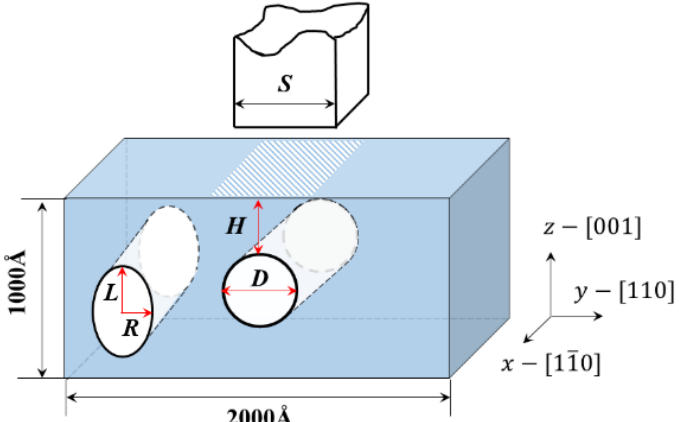
Figure 1. Schematic of the model of a single crystal Al with a lotus-type nanosized cavity during nanoindentation on the (001) surface, where H , D , R , and L are the depth between the top surface of the slab and the cavity top, the diameter of a circular cavity, the half-width and the half-height of an ellipsoidal cavity, respectively, and S is the width of the indenter.